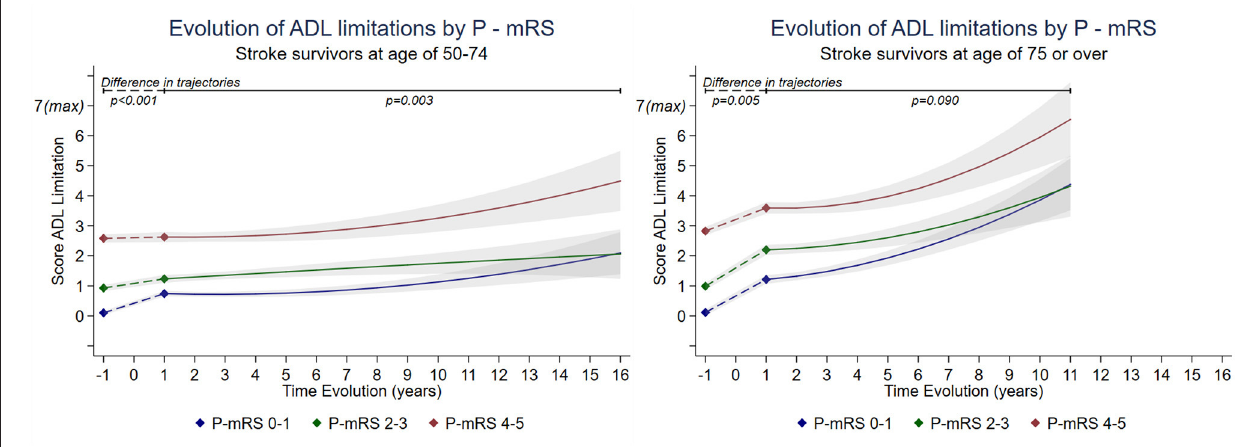
FIGURE 2 | Long-term trajectories of score of ADL limitations in stroke survivors by premorbid modified Rankin scale (P-mRS) stratified by age*. *Estimated from piecewise linear mixed model adjusted for socioeconomic variables, pre-stroke wave data collection, heath behaviors, BMI, and number of comorbidities. Breakpoint was set at 1 year post-stroke. Detailed changes in limitations between pre-stroke and 1 year post-stroke could not be modeled due to lack of information and was assumed linear for the sake of the analysis. ADL score range from 0 = no limitation to 7 = maximum limitation. Estimations are presented for a 16 year follow-up (corresponding to maximum follow-up with at least 5 participants by level of mRS) for population aged 50–74 years and a 11 year follow-up for those aged ≥ 75 years. Supplementary Table 4